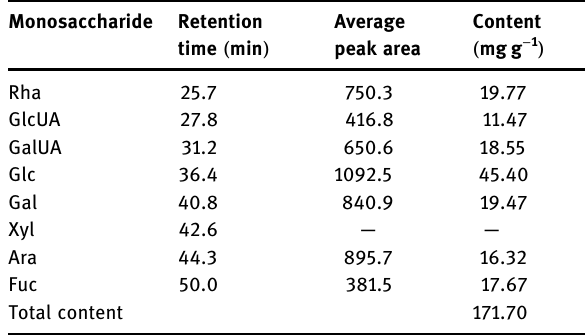
Table 4: Methodology investigation result of monosaccharide content determination in RPS